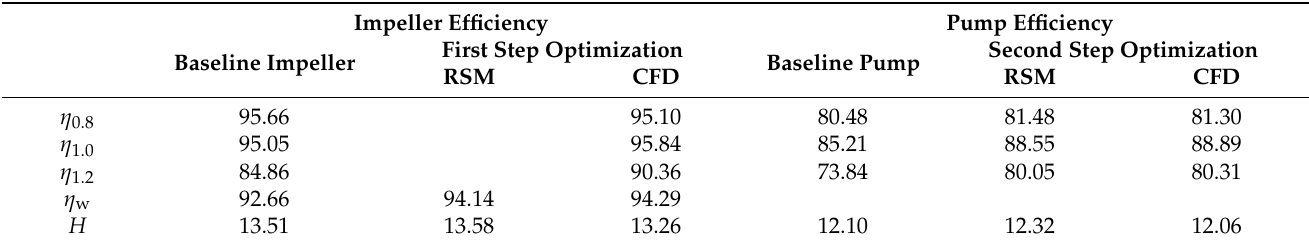
Figure 8. Optimization results of the first step.